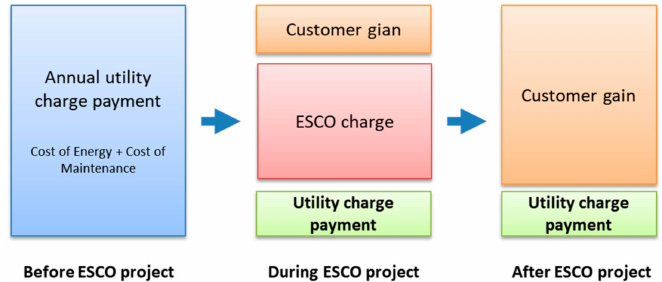
Figure 1. Energy service company (ESCO) transaction structure. Source: